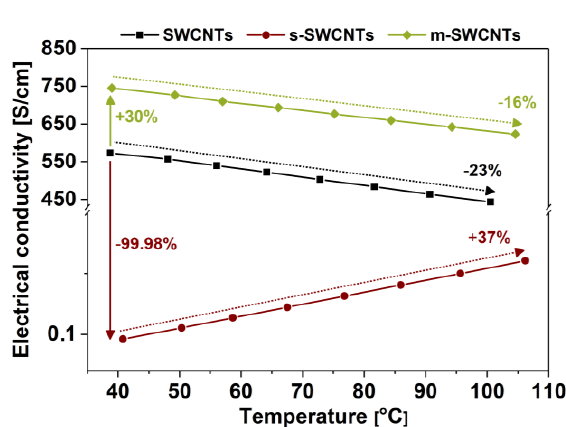
Figure 7. Electrical conductivity of thin films from unsorted, metallic, and semiconducting SWCNTs. Horizontal arrows compare the increase or decrease of the initial electrical conductivity of metallic and semiconducting films as related to the parent material. The arrows, which span across selected temperature ranges, on the other hand, compare the electrical conductivity of the respective SWCNT networks as related to the initial value of electrical conductivity recorded at the starting temperature.